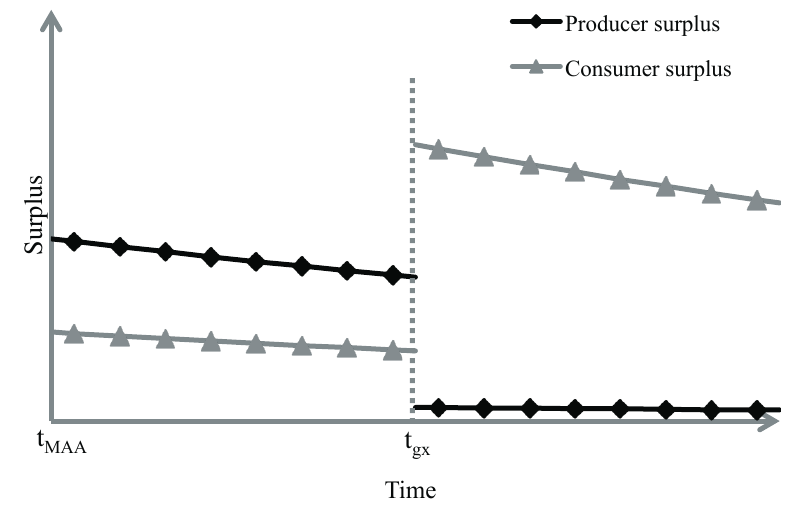
Figure 2: Illustration of producer and consumer surplus during the time of market exclusivity (t to t ) and the time post patent MAA gx